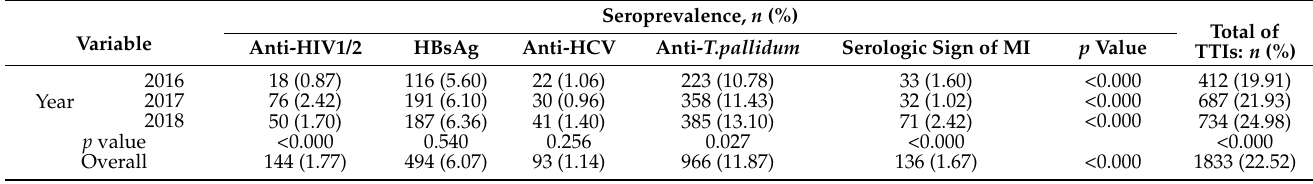
Seroprevalence, n (%)